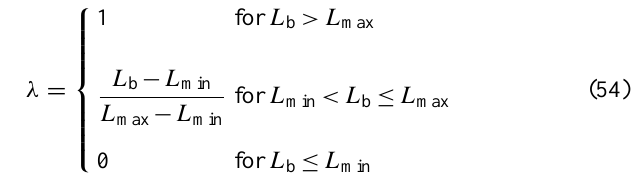
Live stemwood coefficient Specific leaf